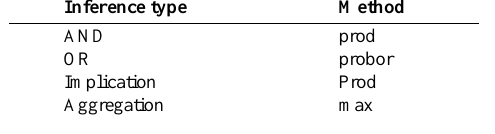
Table 2. Properties of constructed model (Genfis2). Inference type